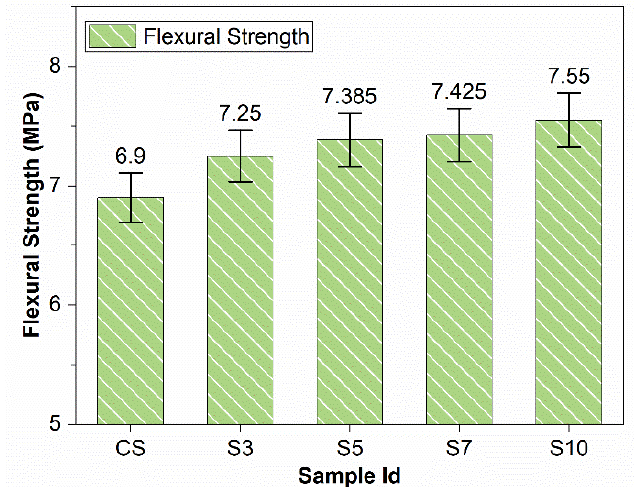
Figure 3. Flexural Strengths of Modified Concrete (ASTM C78).